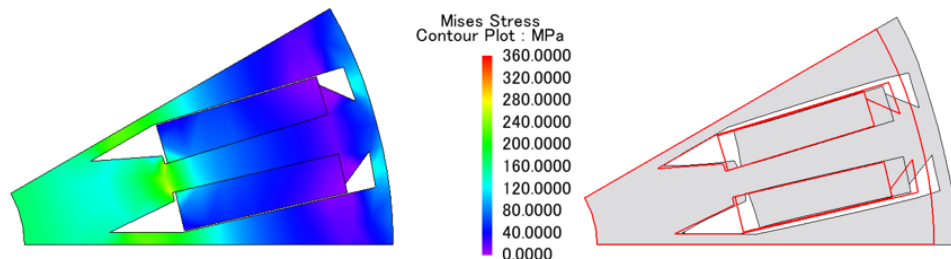
Figure 4. Mechanical simulation of rotor core at overspeed in JMAG. Left : Levels of Stress. Right : Deformation of rotor amplified at 100